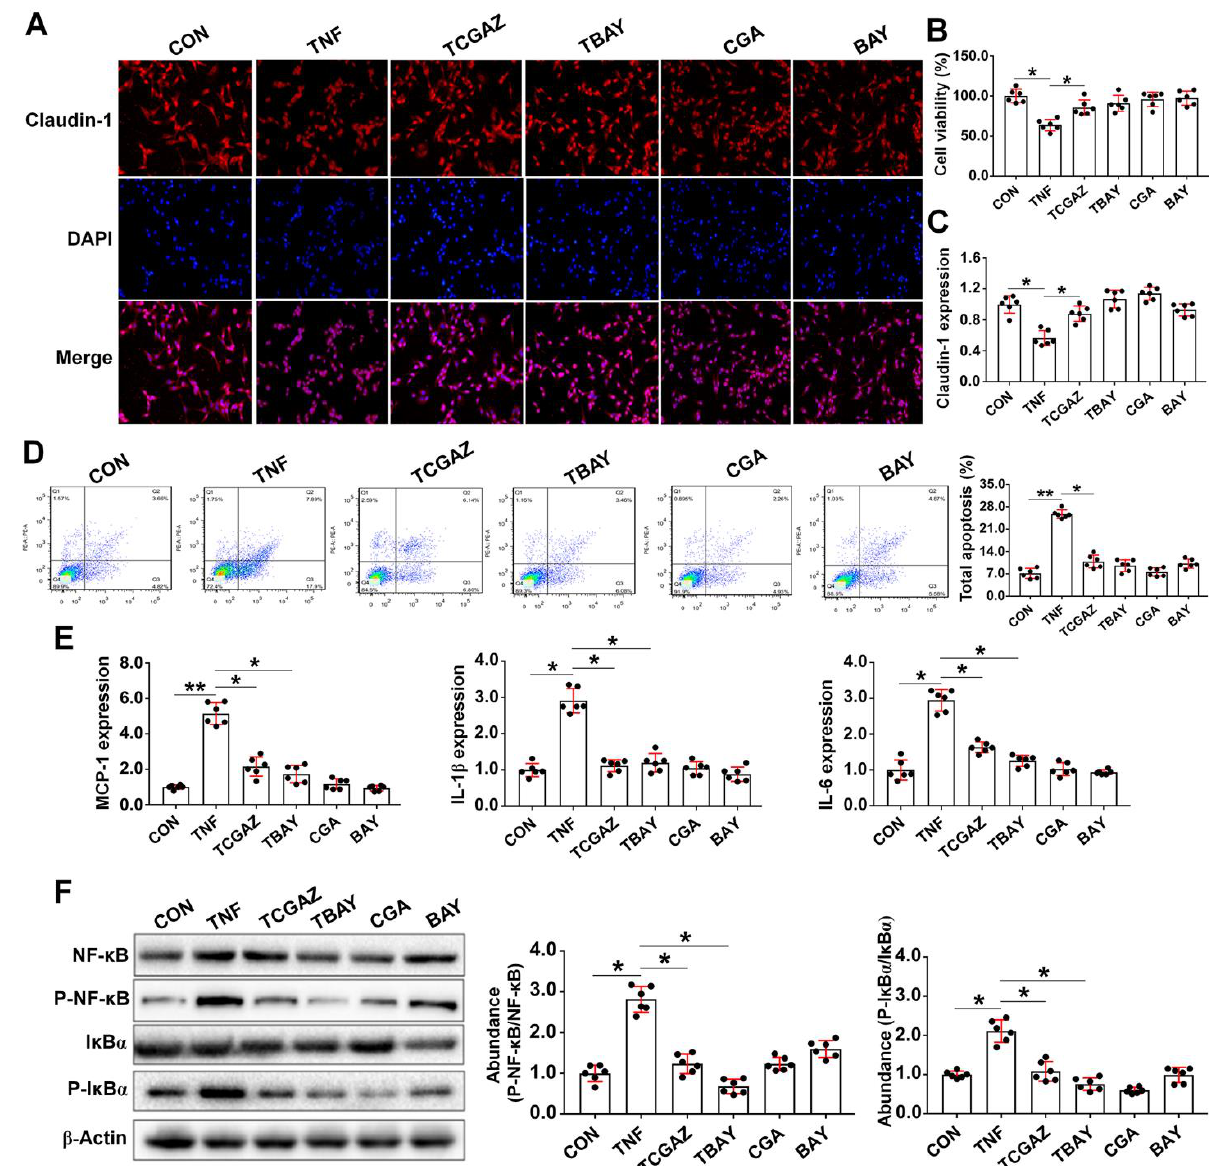
Figure 6. Chlorogenic acid (CGA) suppresses tumor necrosis factor- α (TNF- α ) induced inflammation and injury that is independent on the phosphatidylinositol-3-kinase (PI3K)/protein kinase B (Akt)/ heme oxygenase-1 (HO-1) pathway. ( A ) Localization of the tight-junction protein claudin-1 by immunofluorescence staining. IPEC-J2 cells were plated in 24-well plates at a density of 1 × 10 5 cells/well ( n = 6). ( B ) Assays of cell viability. ( C ) qPCR expressions of claudin-1. ( D ) Analysis of cell apoptosis by flow cytometric assays. In each diagram, Q1 represents the percentage of nonviable and necrotic cells, Q2 represents the percentage of late apoptotic cells, Q3 represents the percentages of early apoptotic cells, and Q4 represents the percentage of live cells. ( E ) Expressions of critical inflammation-related molecules. ( F ) Western-blot analysis of critical signaling proteins involved in the NF-kappa- B inhibitor alpha (IκBα)/nuclear factor - κB (NF - κB) pathway. CON, cells without being treated; TNF, cells were treated by 50 ng/mL TNF- α; TCGAZ, cells were pretreated by 10 μM Zn-protoporphyrin-IX (ZnPPIX, the specific inhibitor of HO-1) for 1 h and were then treated by 50 µM CGA and 50 ng/mL TNF- α; TBAY, cells were pretreated by 20 μM (E)3 -[(4-methylphenyl)-sulfonyl]-2-propenenitrile (BAY11-7082, the specific NF- κB inhibitor) and were then treated by 50 ng /mL TNF- α; CGA, cells were only treated by 50 μM CGA; BAY, cells were only treated by 20 µM BAY11-7082. * p < 0.05, ** p < 0.01.